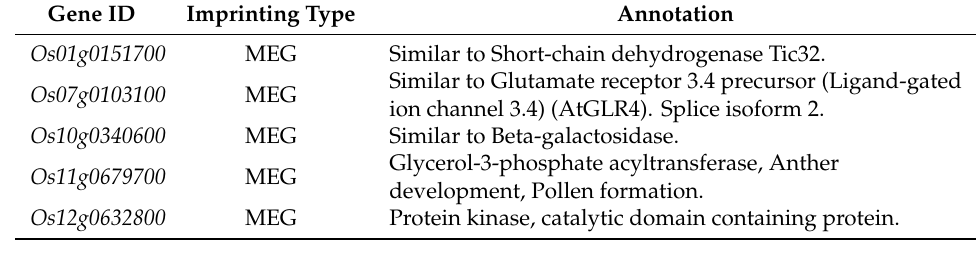
Table 4. Five common MEGs detected among three reciprocal crosses.